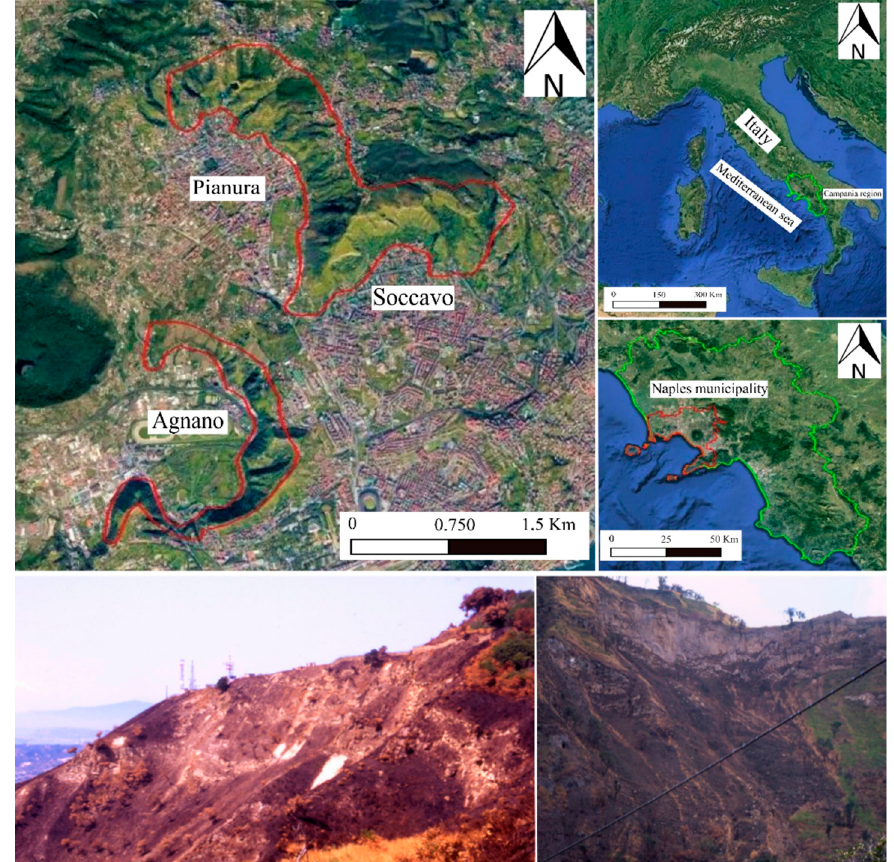
Figure 1. Location of the study area. In the top-left inset, the study area in detail; in red, the Camaldoli and Agnano hills. In the bottom-left inset, post-fire erosion phenomena (15 September 2001); in the bottom-right inset, the post-fire landslides triggered in the summer of 1996. Both images refer to the Soccavo slopes (photo: D. Calcaterra).